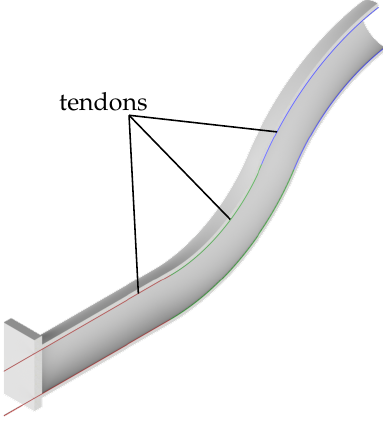
Figure 1. Cut through the soft